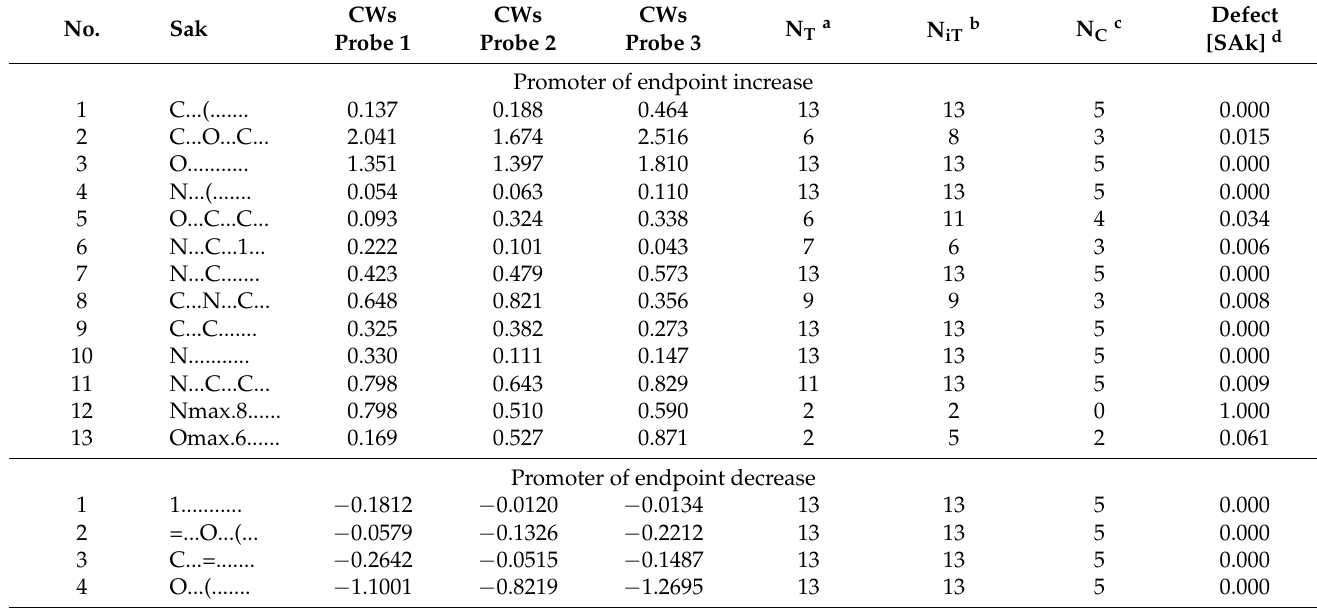
Table 2. Promoters of increase and decrease of pEC 50 endpoint from split